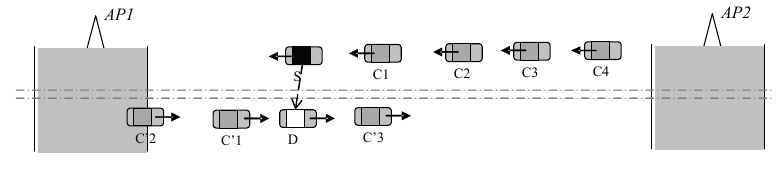
Figure 4. The experiment scenario.